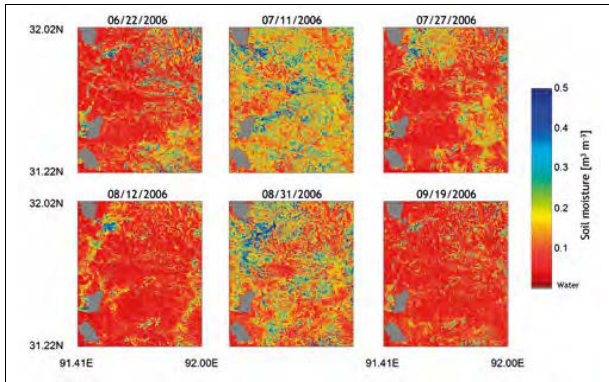
Figure 6. Soil moisture maps derived from ASAR WS images (Van der Velde et al. 2012)